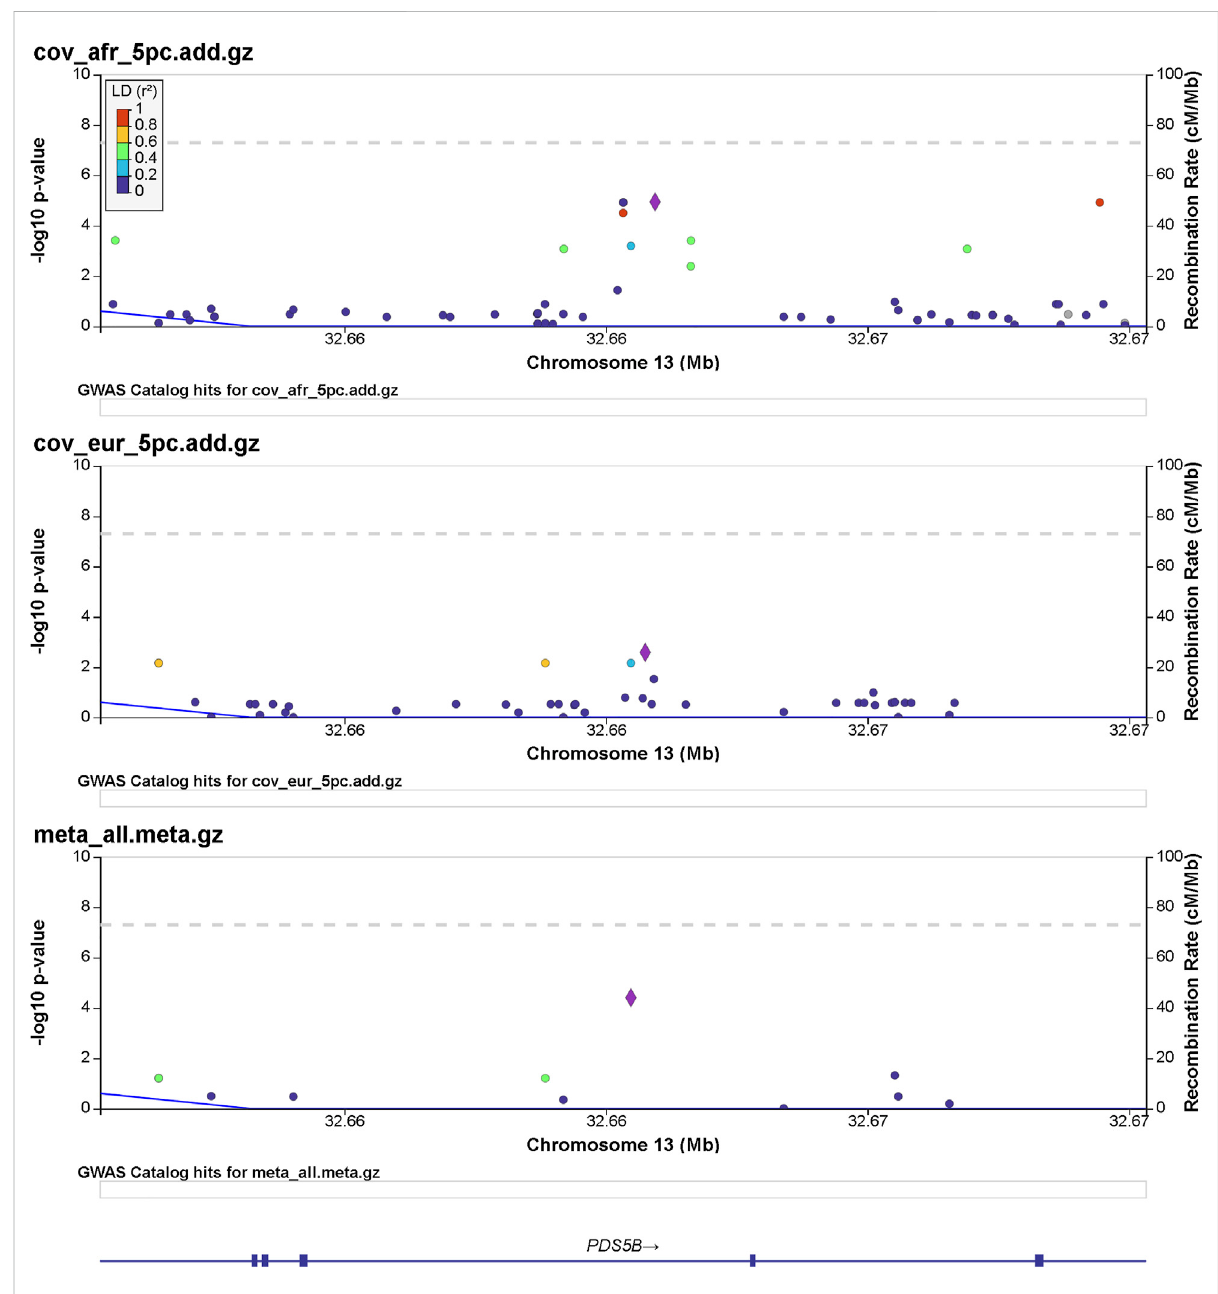
FIGURE 2 Regionalsigni fi canceplotofthe13q13.1regionbyLocusZoom(Pruimetal.,2010).ThePDS5cohesin-associatedfactorBgene( PDS5B )mapsto this region. The peak of signi fi cance by the meta-analysis is from the SNP 13:32665329:A:C (rs144965594) at the intronic region of PDS5B